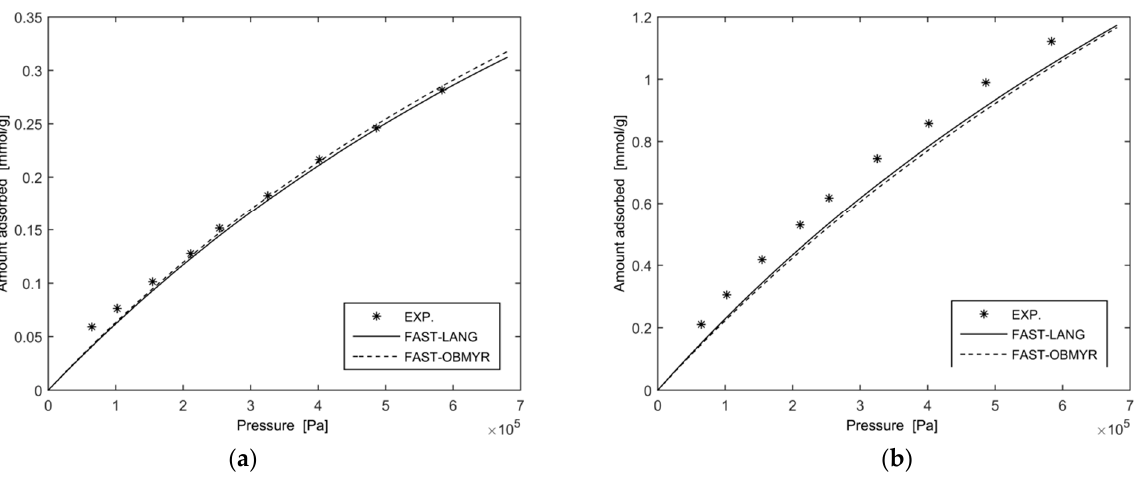
Figure 3. Adsorption results for ( a ) nitrogen and ( b ) methane, as experimentally observed and as obtained with the two implemented models of the Fast-IAS theory.